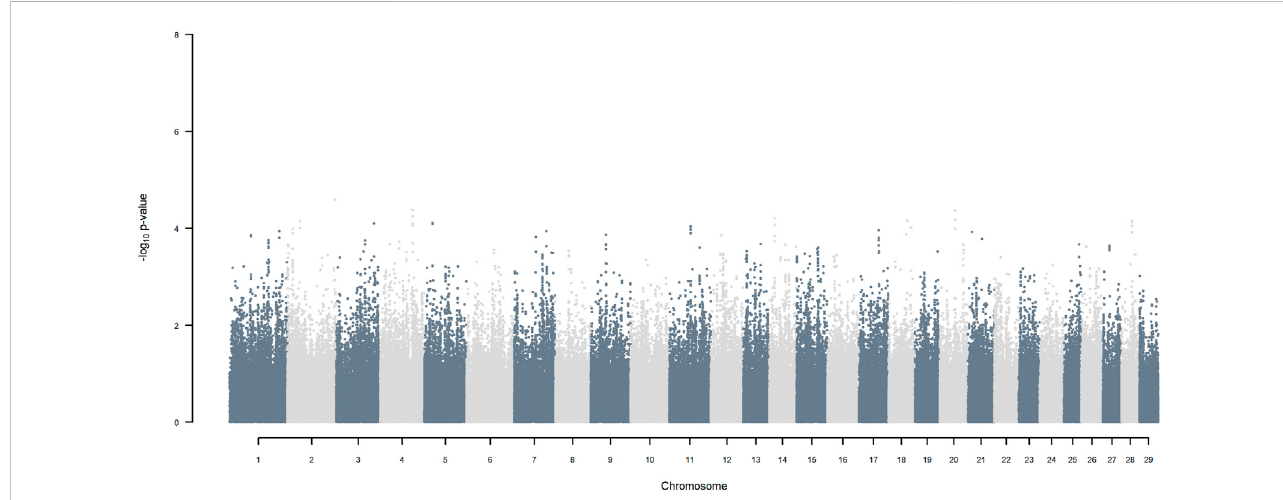
FIGURE 9 Manhattan plot of GWAS (Models 3 & 4) for SNP allele of HF origin using SNP alleles of all origins that had a MAF > 1%.